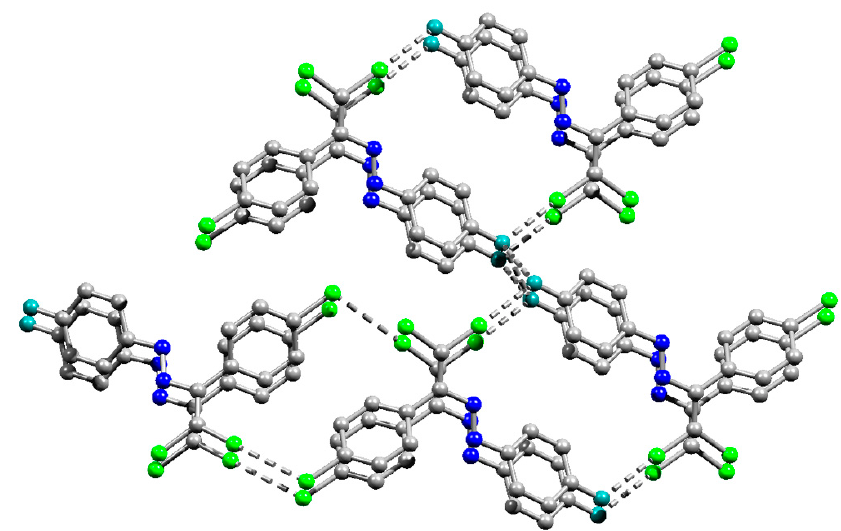
Figure 4. Ball-and-stick representation of 13 and its self-assembly via Cl ··· Cl bonding in the crystal. Blue, green, and grey and cyan spheres represent nitrogen, chlorine, carbon, and fluorine atoms, respectively. Hydrogen atoms were omitted for clarity.